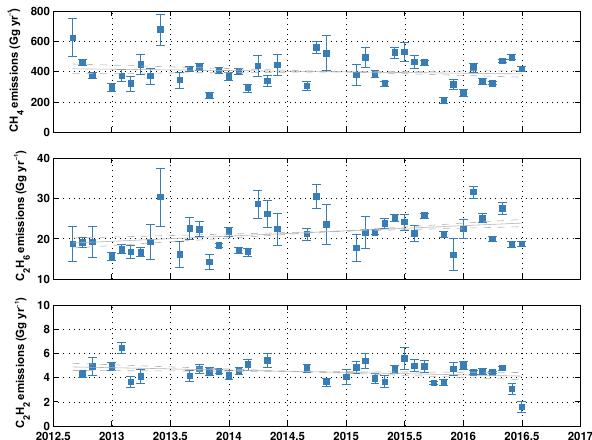
Figure 4. This plot shows the monthly methane (top), ethane (mid- dle), and acetylene (bottom) emissions measured in the atmosphere by the Caltech FTS (blue squares). Grey solid lines indicate the best-fit slopes with standard errors indicated by the grey dashed